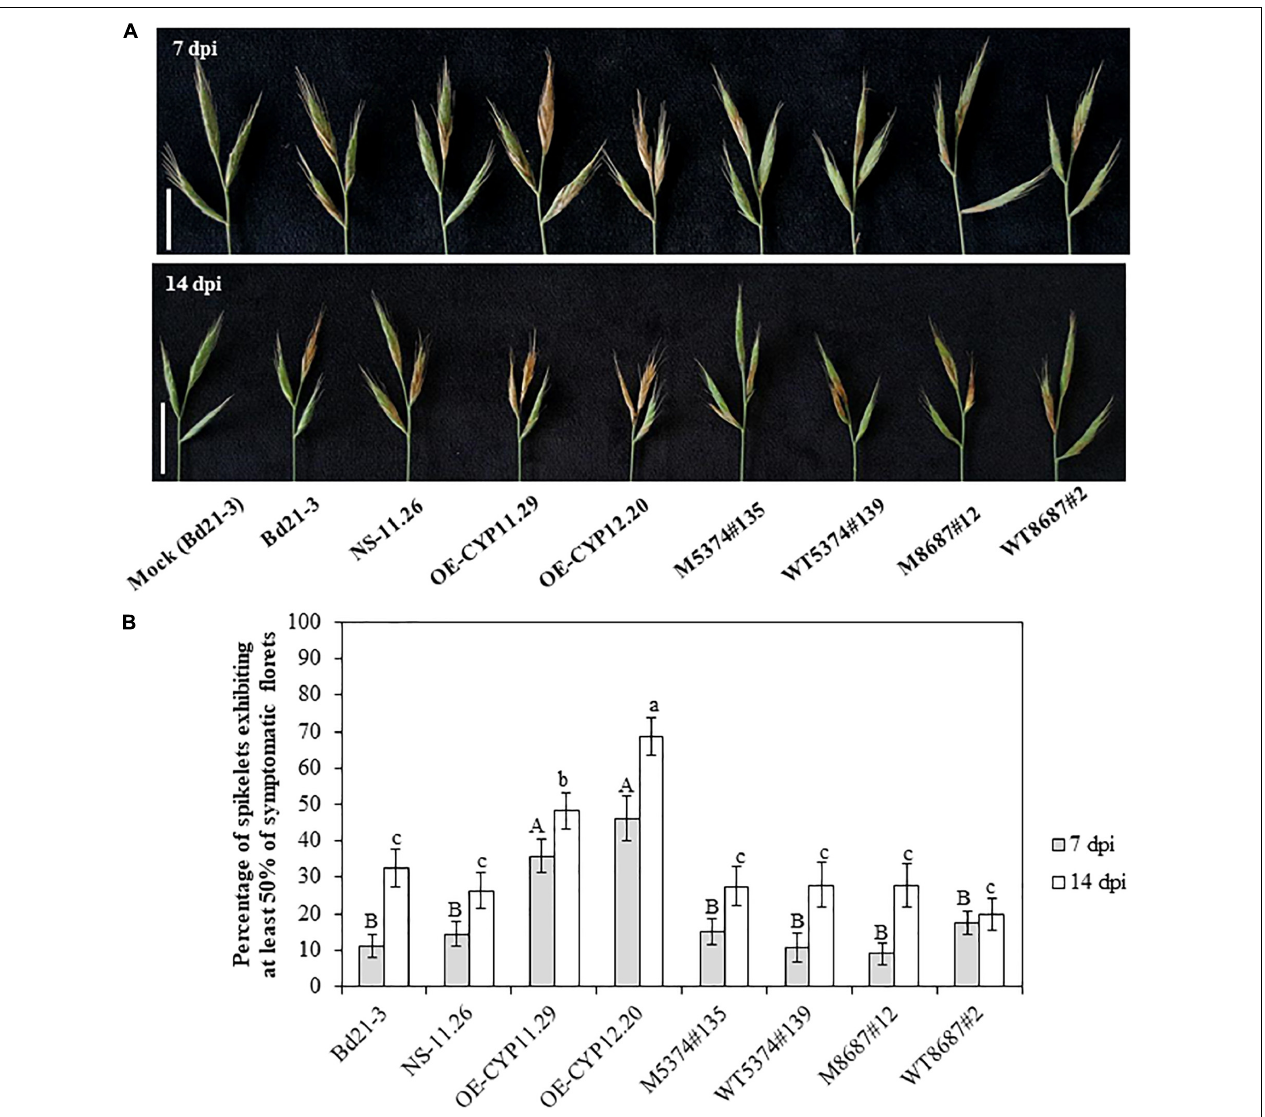
FIGURE 6 | Overexpression of the BdCYP711A29 gene increases FHB susceptibility following spray inoculation of F. graminearum . (A) Typical FHB symptoms at 7 and 14 days following spray inoculation of whole spikes of the different lines by the F. graminearum FgDON + strain. Bars equal 1 cm. (B) Percentage of spikelets exhibiting FHB symptoms on at least 50% of the florets of the inoculated spikes at 7 and 14 dpi by the PH-1 strain. Mean of four independent biological replicates ( n = 52). Different letters indicate significant differences between conditions; upper case and lower case letters indicate the statistical comparison at 7 and 14 dpi, respectively ( p- value < 0.05, Tukey’s